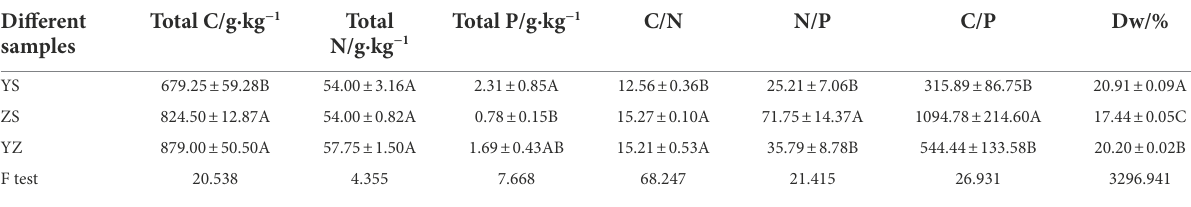
TABLE 1 Differences in physicochemical properties of three types of litter.